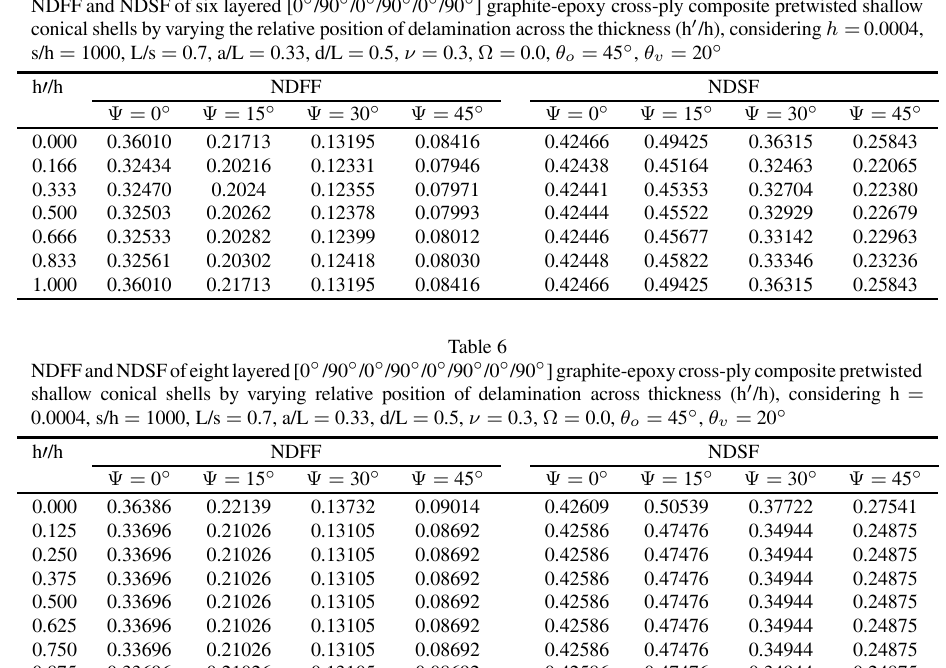
Table 5 NDFF and NDSF of six layered [0 ◦ /90 ◦ /0 ◦ /90 ◦ /0 ◦ /90 ◦ ] graphite-epoxy cross-ply composite pretwisted